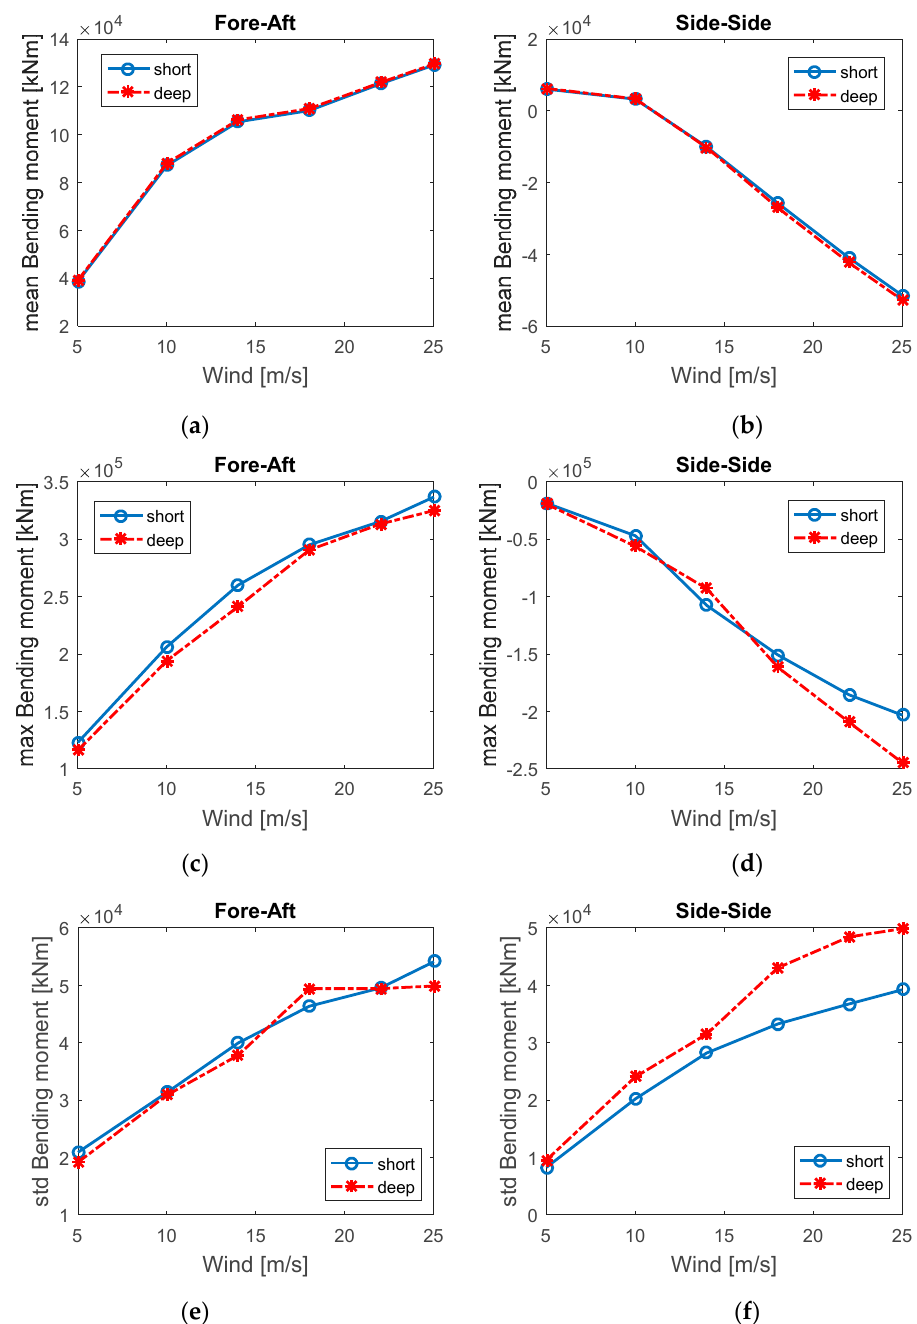
Figure 12. Statistics of tower base bending moment for the short spar and deep spar VAWTs: ( a ) Mean values in fore–aft; ( b ) Mean values in side–side; ( c ) Maxima values in fore–aft; ( d ) Maxima values in side–side; ( e ) Standard deviations in fore–aft; ( f ) Standard deviations in